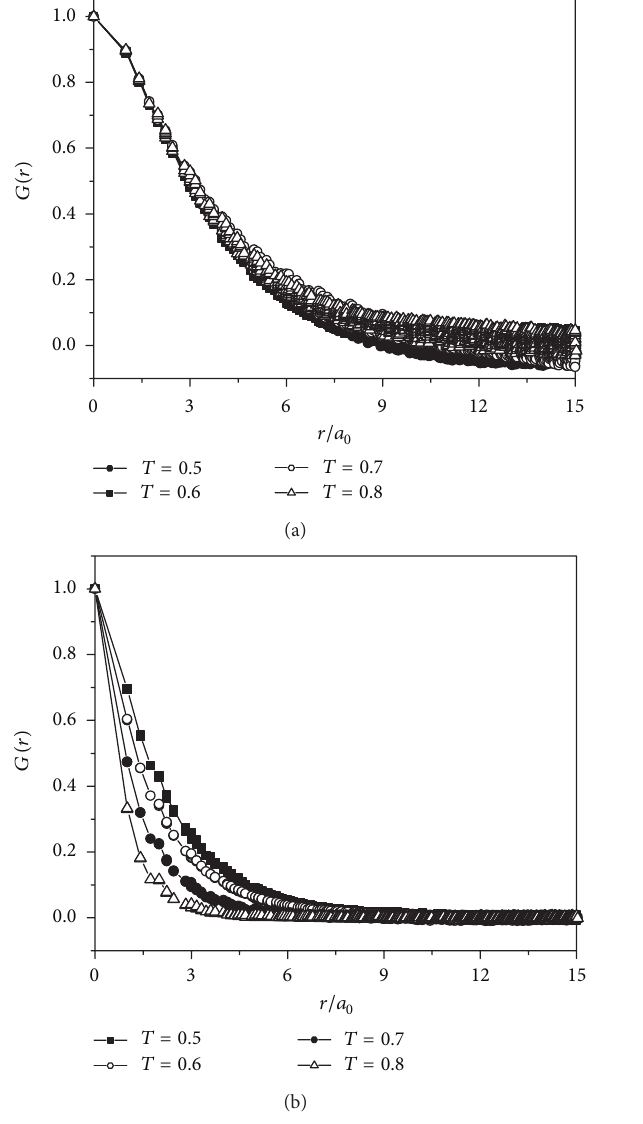
Figure 7: 𝐺(𝑟) dependence for random histories . (a) 𝑃 = 0.1 , (b) 𝑃 = 0.3 . 𝑊 = 1 , 𝑁 = 60 .